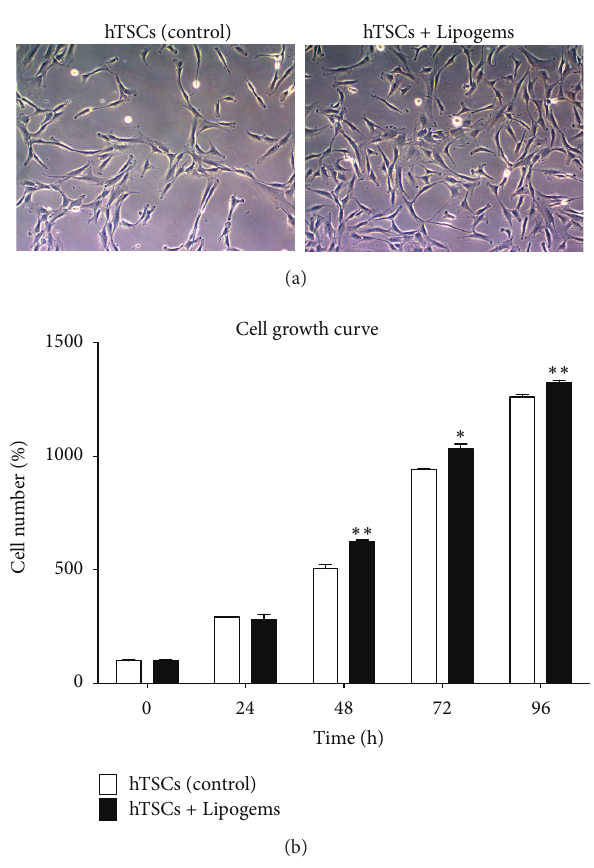
Figure 2: Effects of the Lipogems product on hTSCs morphology and proliferation. (a) Phase-contrast microphotographs (original magnification × 10) and (b) cell growth curves of hTSCs during 96h treatment with the Lipogems product in normal growth medium and compared to control cells. All experiments were performed in triplicate. Error bars show the mean ± SD of three different experiments. 𝑝 values were calculated using Student’s 𝑡 -test. Only 𝑝 values < 0.05 are indicated: ∗ 𝑝 < 0.05 ; ∗∗ 𝑝 < 0.01 , as compared to control